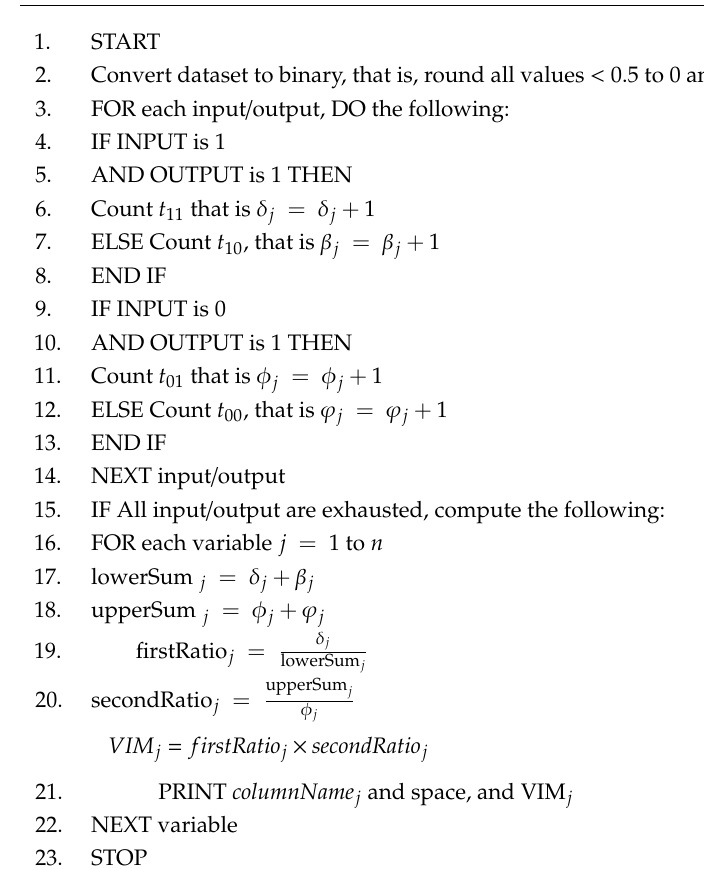
Algorithm 1. Pseudo